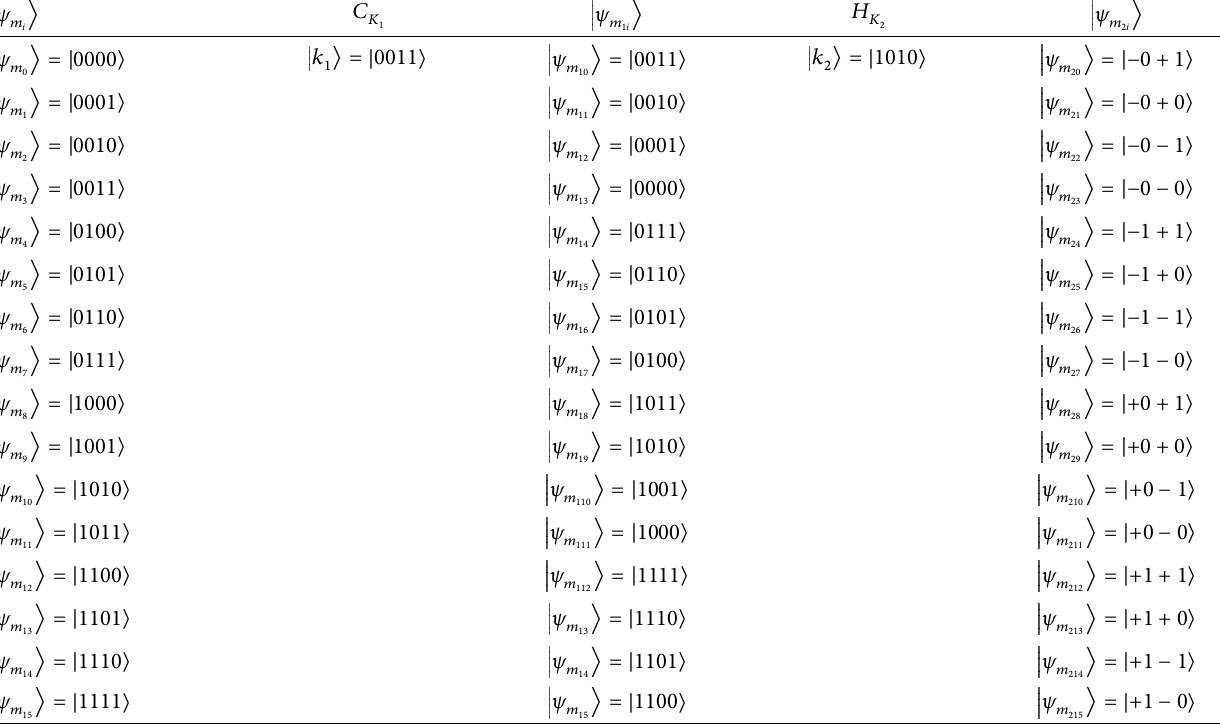
Table 3: Complete operation of four qubit quantum system.